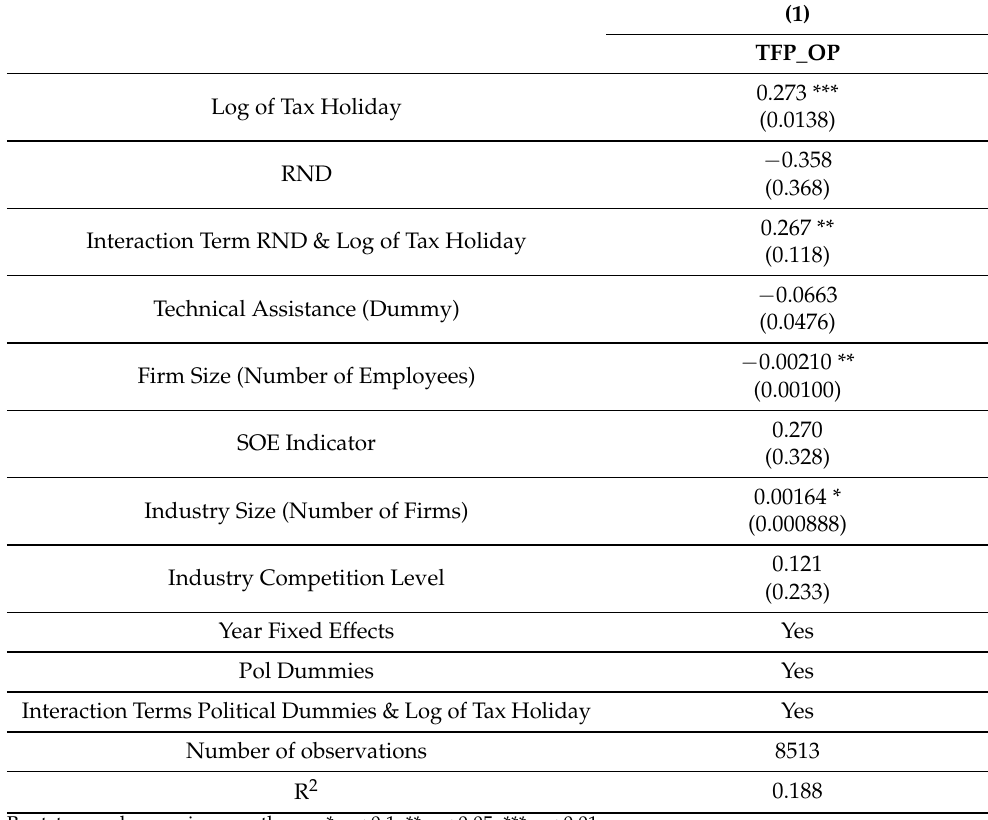
Table A6. Robustness Checks on R&D Intensity with Bootstrapped Errors.